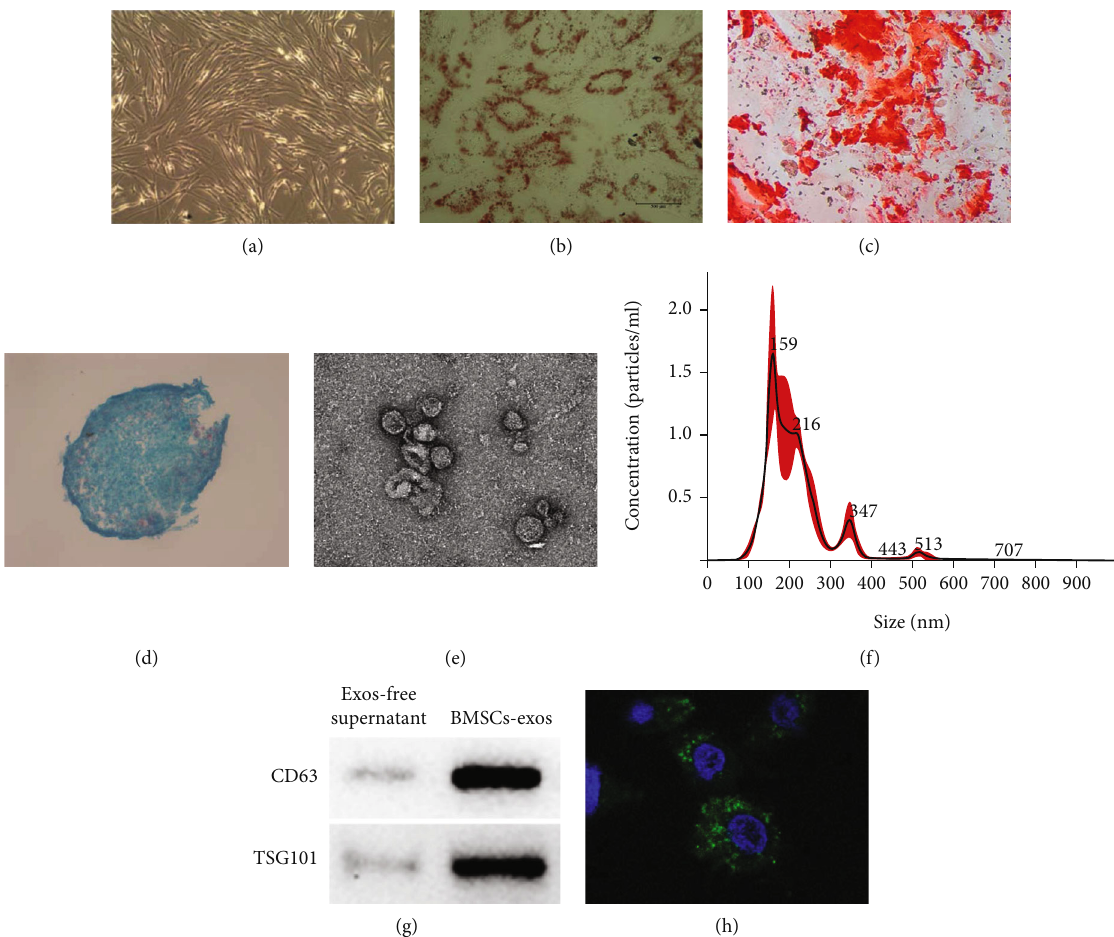
Figure 1: Identi fi cation of BMSCs and BMSC-exos. (a) The morphology of BMSCs was observed with an inverted microscope. (b – d) The multidi ff erentiation potential of BMSCs was identi fi ed, respectively, with Alizarin red S staining (b), oil red O staining (c), or Alcian blue staining (d) in vitro. (e – h) The extracted exosomes from BMSCs were further validated by transmission electron microscopy (TEM), nanoparticle tracking analysis (NTA), and western blotting. (e) TEM showed that BMSC-derived exosomes ’ morphology was circular and cup-shaped (100-200nm in diameter). (f) NTA showed BMSC-exo size distribution. (g) Western blotting showed that BMSC-exos have specialized markers CD63 and TSG101. (h) Immuno fl uorescence image showing MLE-12 cells incubated with PKH67-labeled BMSC-exos (green) for 24 hours. Cell nuclei were counterstained with Hoechst